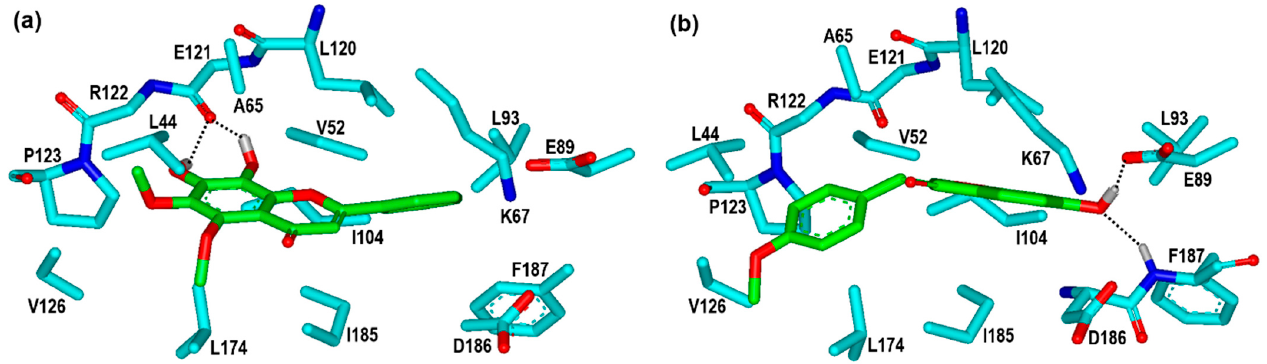
Figure 4. Calculated binding modes of ( a ) 1 and ( b ) 2 in the ATP-binding site of PIM1. Carbon atoms of PIM1 and the inhibitors are indicated in cyan and green, respectively. Dotted lines indicate the hydrogen bonds.